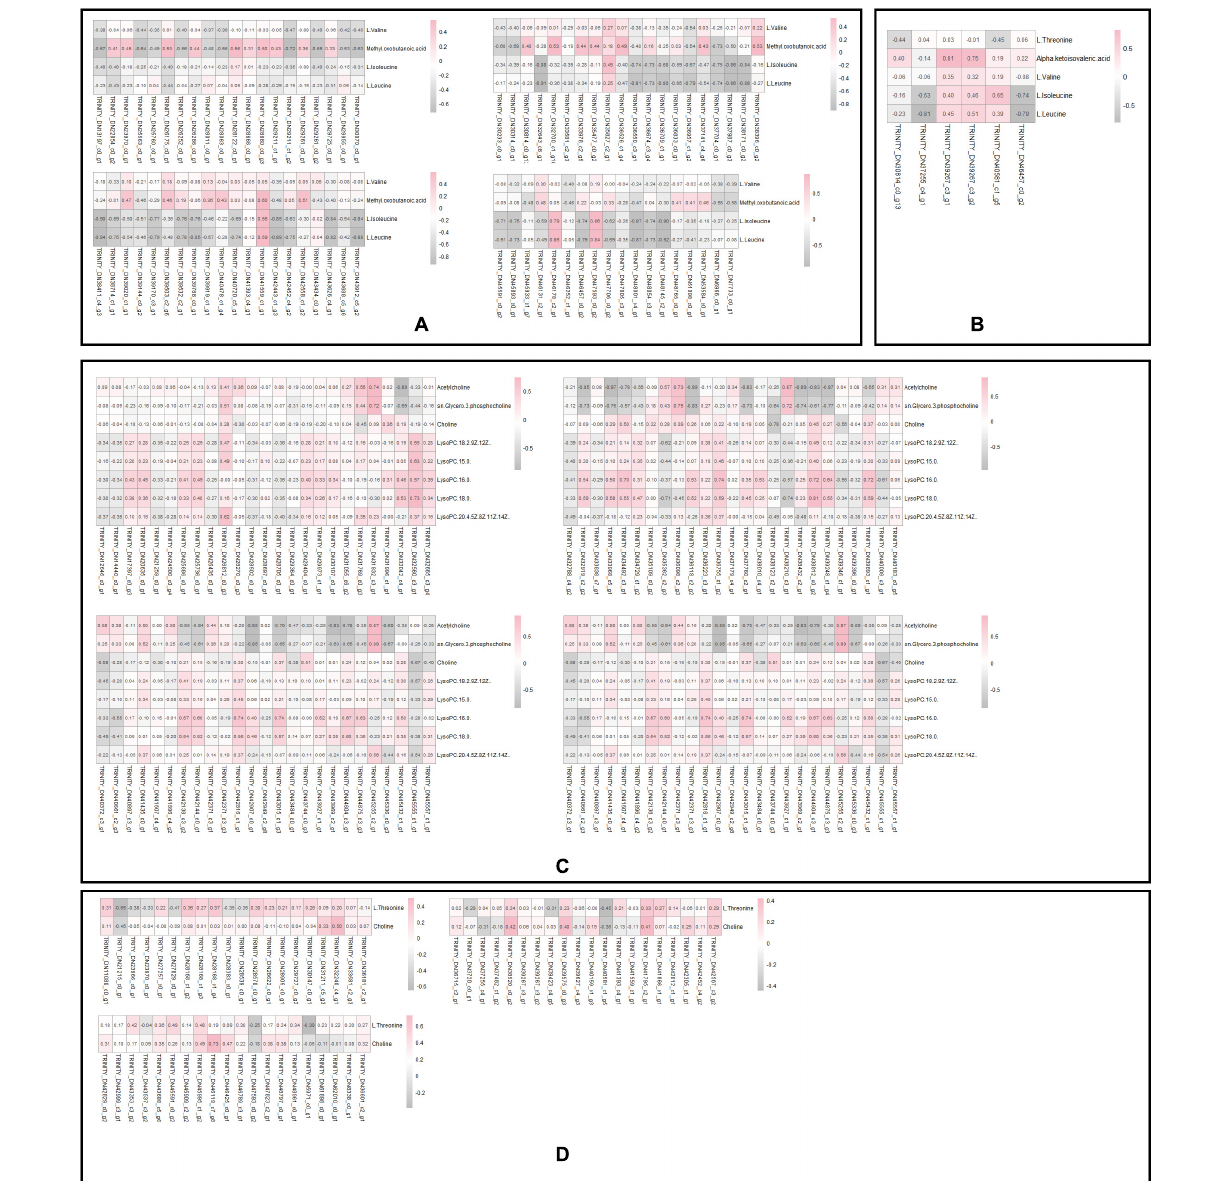
inflammation, immunity, and cell survival (Karin and Lin,